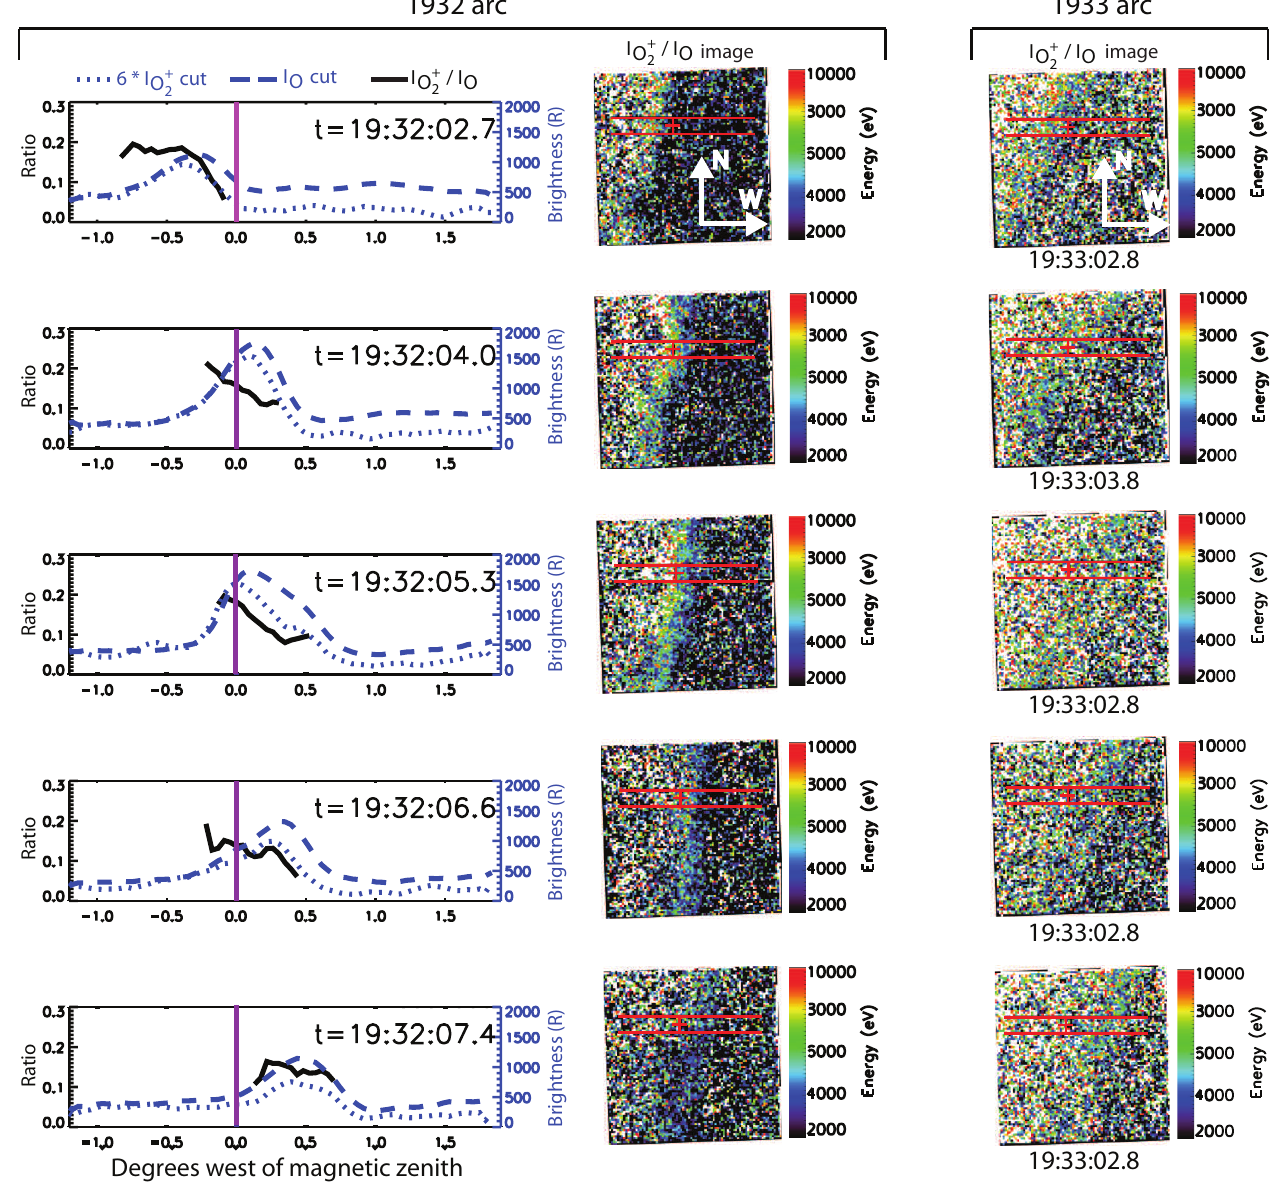
Fig. 6. Left: I (blue dotted line), I O (blue dashed line) and I O + 2 /I O (black) from cuts made through the ASK images at 19:32 UT. Middle: I O + 2 /I O images, giving a 2-D distribution of the energy of the precipitating electrons. The red horizontal lines mark the region of the cut. Magnetic zenith is marked with a cross. Right column: 2-D energy distributions for the 1933 arc. passage of the 1932 arc. The east-west aligned cut is through each time step. Volume emission rates have been modelled as the magnetic zenith, and 8 pixels in the north-south direc- tion are averaged to give a larger SNR. This region is shown by two horizontal lines in the images to the right, with the magnetic zenith shown as a cross. The images in the middle and right columns in Fig. 6 are derived 2-D maps of the av- erage energy at the selected times for the 1932 and 1933 arc, respectively. The intensity of the 1933 arc is weaker, obtained by